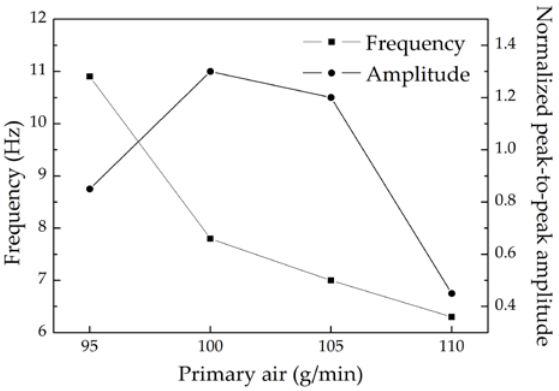
Figure 10. Pulsation frequency and amplitude of flame heat-release rate for primary air mass flow rate.